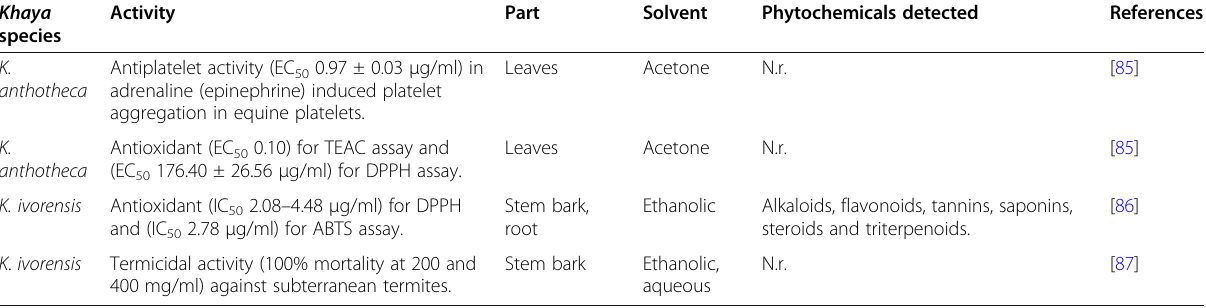
Table 2 Other (non-limonoid) reported bioactivities in the genus Khaya for the period 2000 – 2020